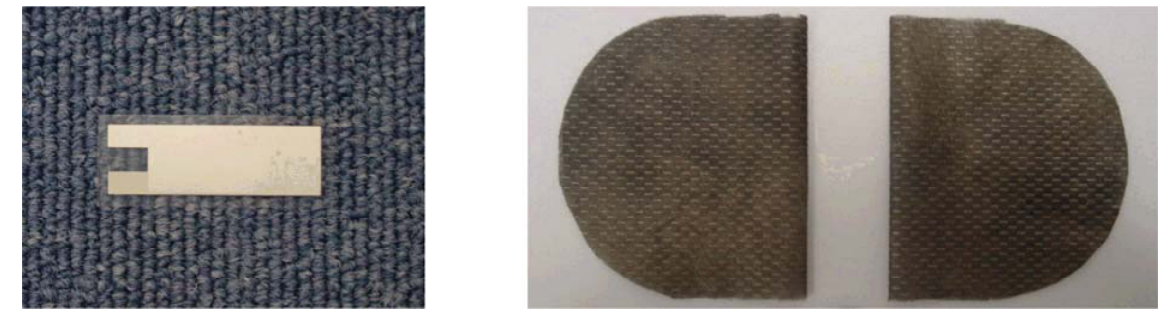
Figure 2. PVDF film sample (left panel) and conductive fabric sheets sample (right